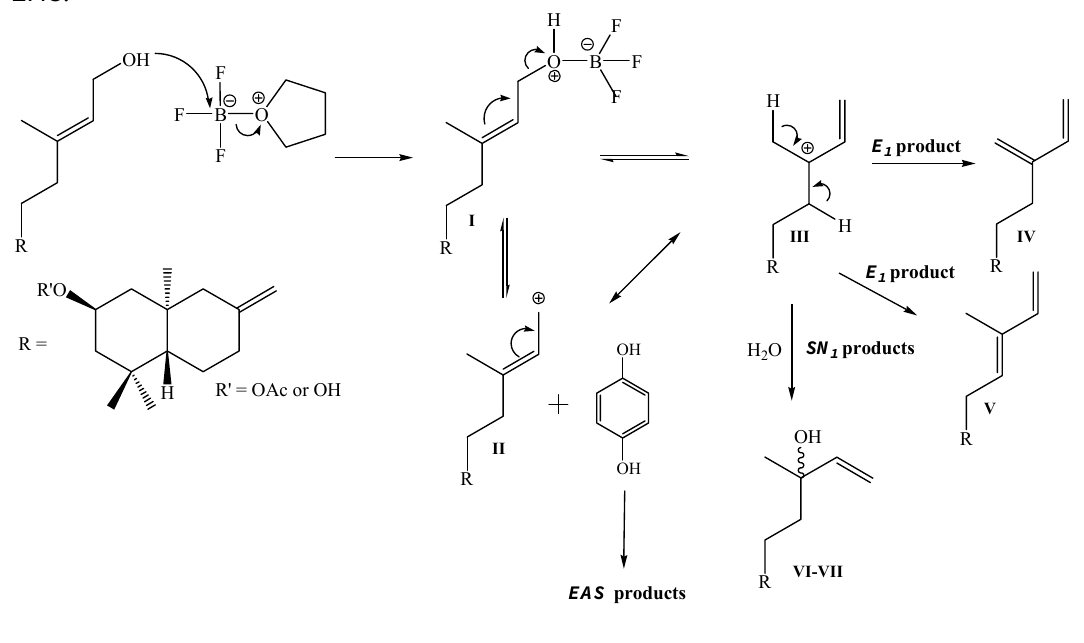
Figure 4. General schemes with probable intermediaries of reaction II and III and E